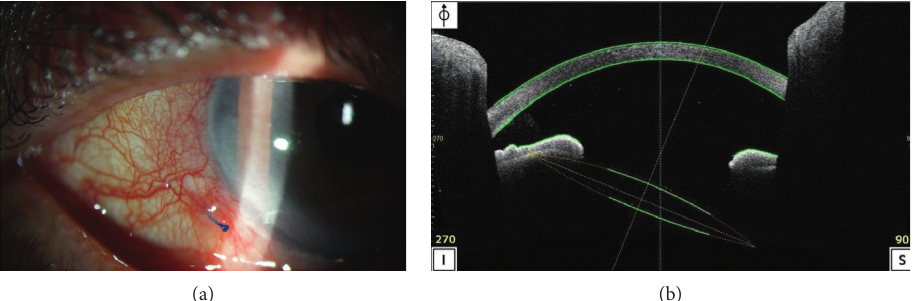
Figure 1: Complications after intrascleral fixation of intraocular lens by the double-needle-flanged technique. (a) Exposure of the flanged haptic and (b) intraocular lens